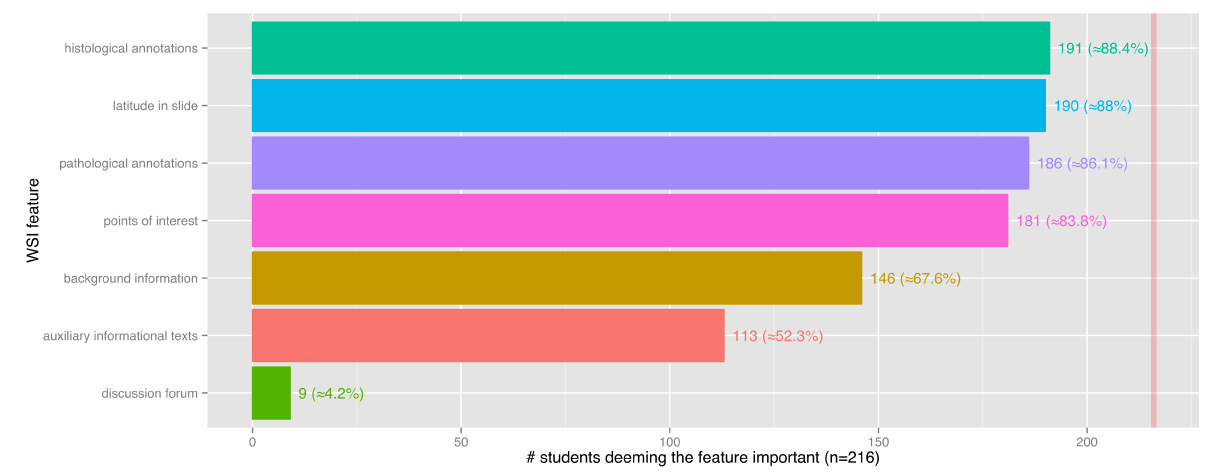
Figure 2. Features for WSI applications in relation to the importance to the